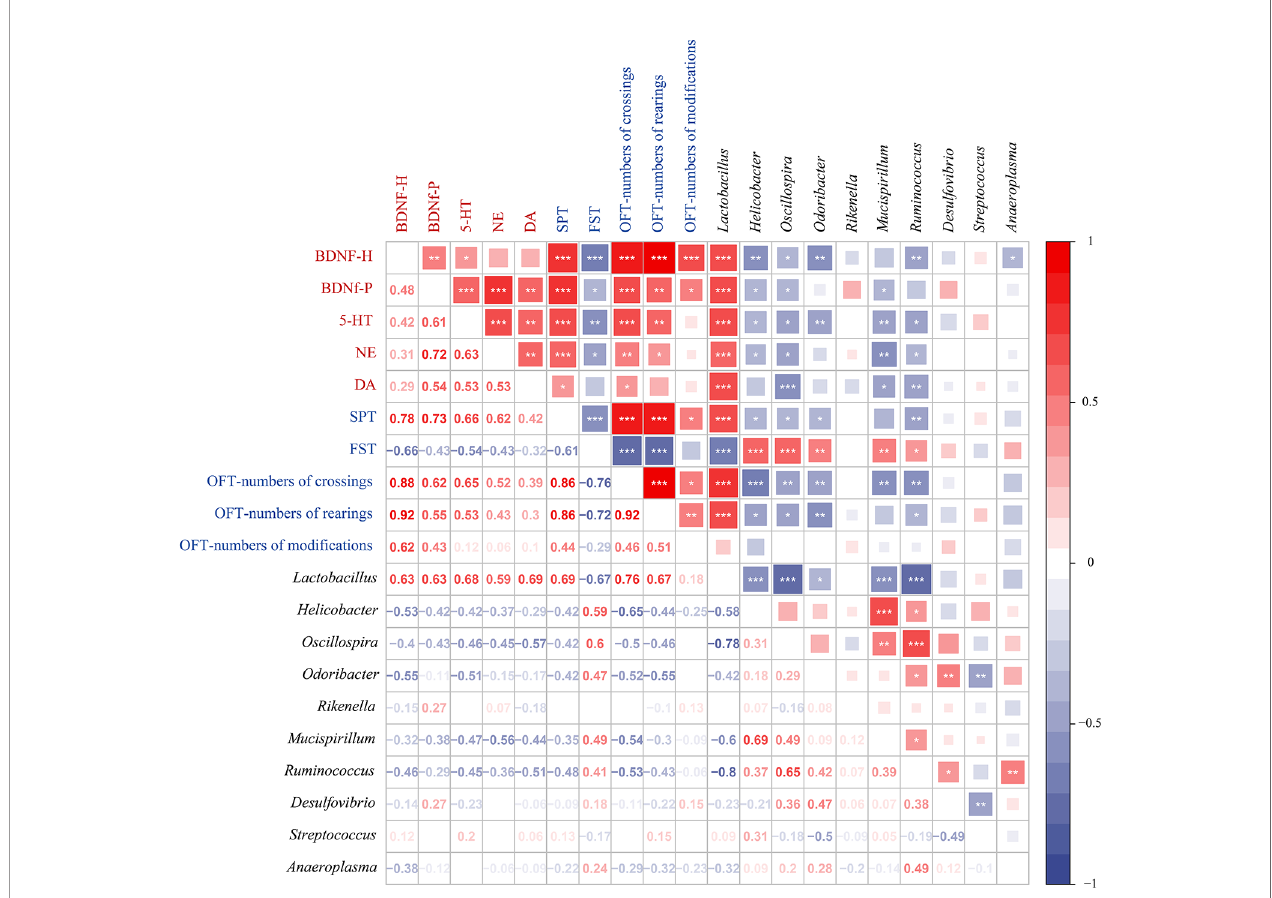
FIGURE 6 | Spearman correlations between gut microbiota, depression-like behaviors, and depression-related indicators. Spearman ’ s rank correlation coef fi cient among 5 depression-related indicators, 5 depression-like behaviors, and 10 gut microbiota that differed signi fi cantly in abundance between different treatment groups. Axis label: red, depression-related indicators; blue, depression-like behaviors; black, gut microbiota. Numbers on the lower left area: value of correlation coef fi cient; symbols on the upper right area: results of correlation and signi fi cance test, * P < 0.05, ** P < 0.01, *** P <